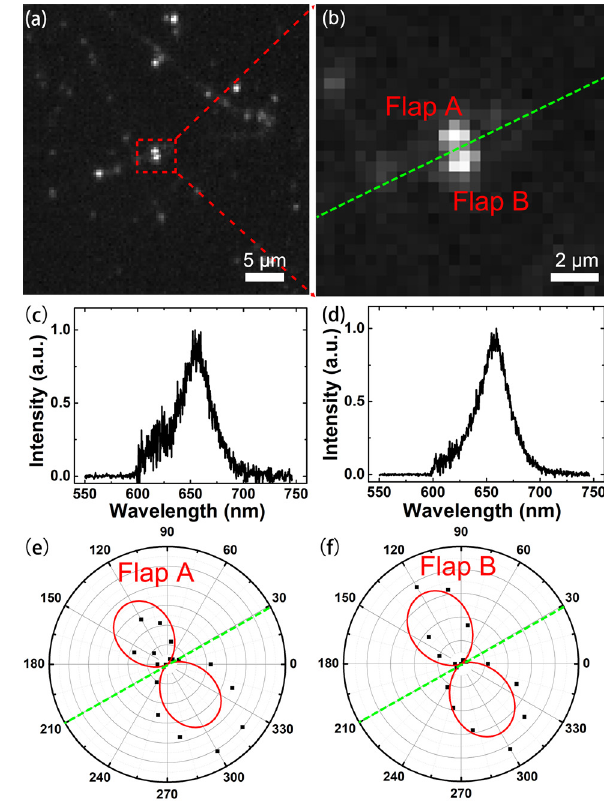
Figure 2: (a) Optical image of the collected photons emitted from thesinglequantumdots.Thescalebaris5 μ m.(b)Zoomed-inoptical image of the splitting spot. The scale bar is 2 μ m. (c) Emission spectrum for the emission with two fl aps. (d) Emission spectrum from the quantum dot on a glass substrate. Polar plots of the measured emission intensities of (e) Flap A and (f) Flap B as a function of the polarizer